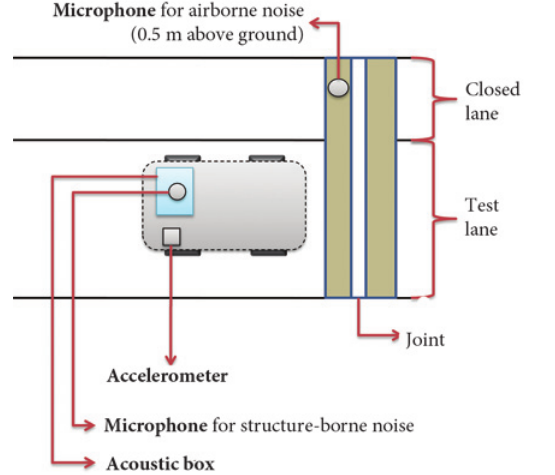
Fig. 5. Setup schematic of Acoustic-Box-in-Vehicle